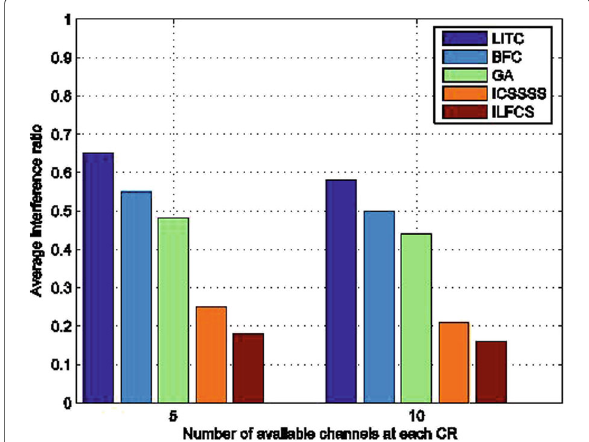
Fig.18 Spectrum opportunity utilization for LITC, BFC, GA, ICSSSS, and ILFCS in case of long-term PU activity. Shows the results of different simulation experiments to measure Spectrum opportunity utilization for LITC, BFC, GA, ICSSSS, and ILFCS in case of long-term PU